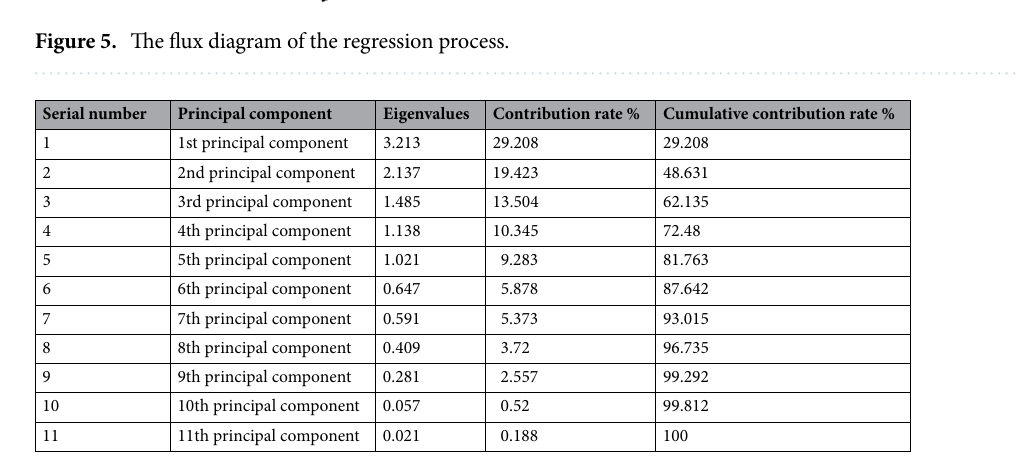
Table 3. Principal component characteristic value and contribution rate of air pollutant concentration and climate